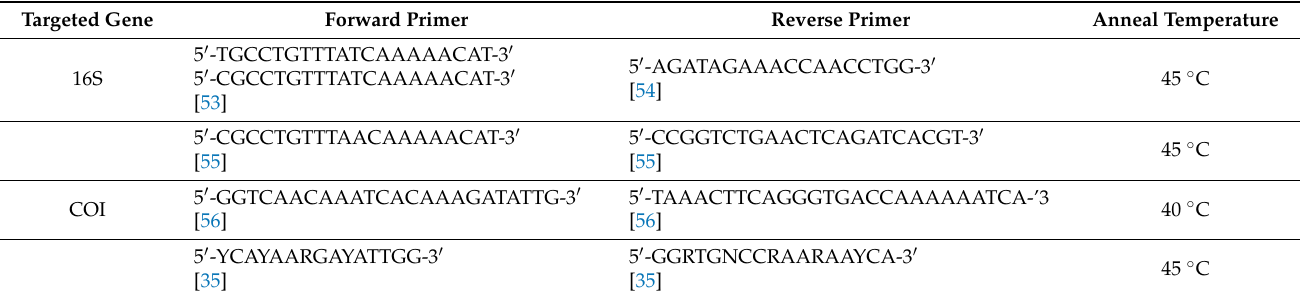
Table 1. The targeted genes, primer sequences and annealing temperatures used in this study. Targeted